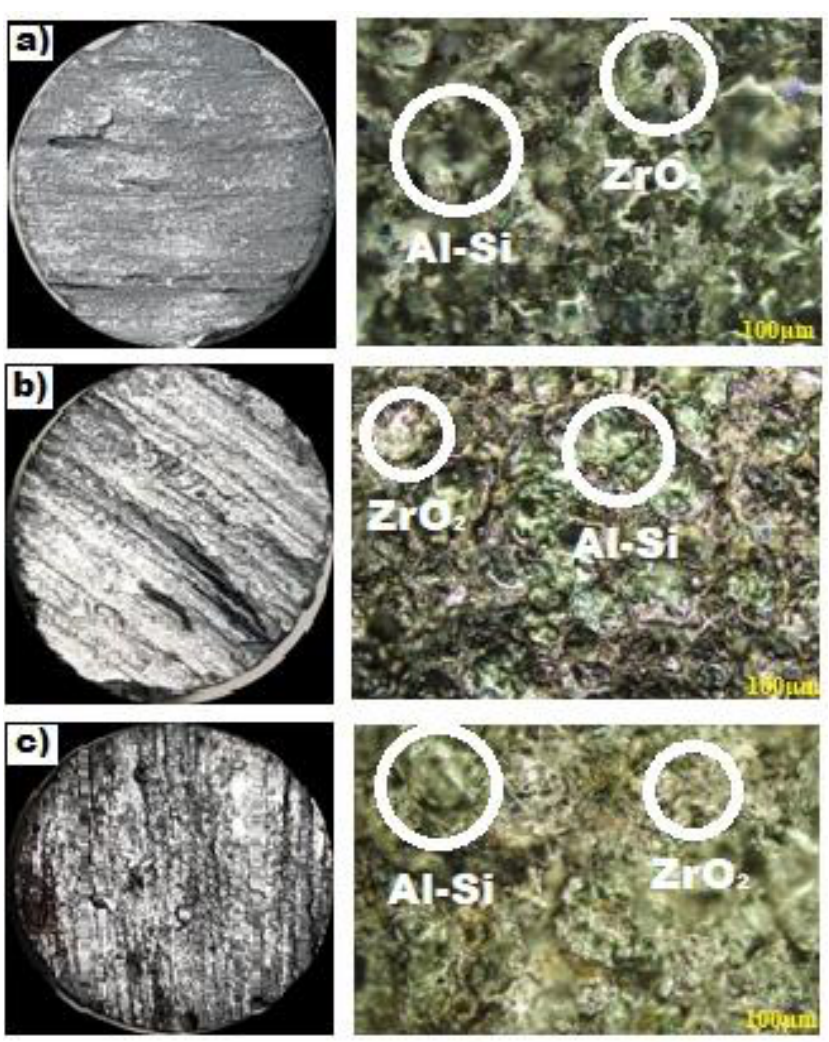
Figure 25. Microstructural changes of Si-Al (13 wt.% Si) ( a ) ZrO 2 (5 wt.%), load (19.62 N), and sliding speed (1.67 m/s); ( b ) ZrO 2 (10 wt.%), load (19.62 N), and sliding speed (1.67 m/s); ( c ) ZrO 2 (15 wt.%), load (19.62 N), and sliding speed (1.67 m/s).